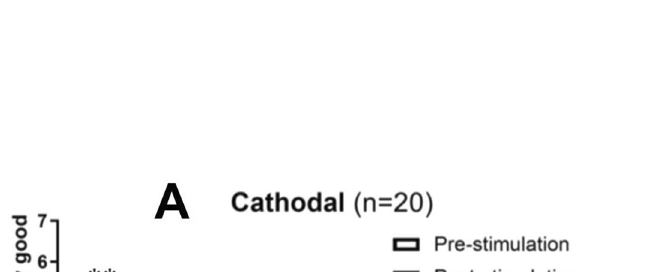
Table 1. Ages and emotion scores for tDCS groups (mean ± SD).